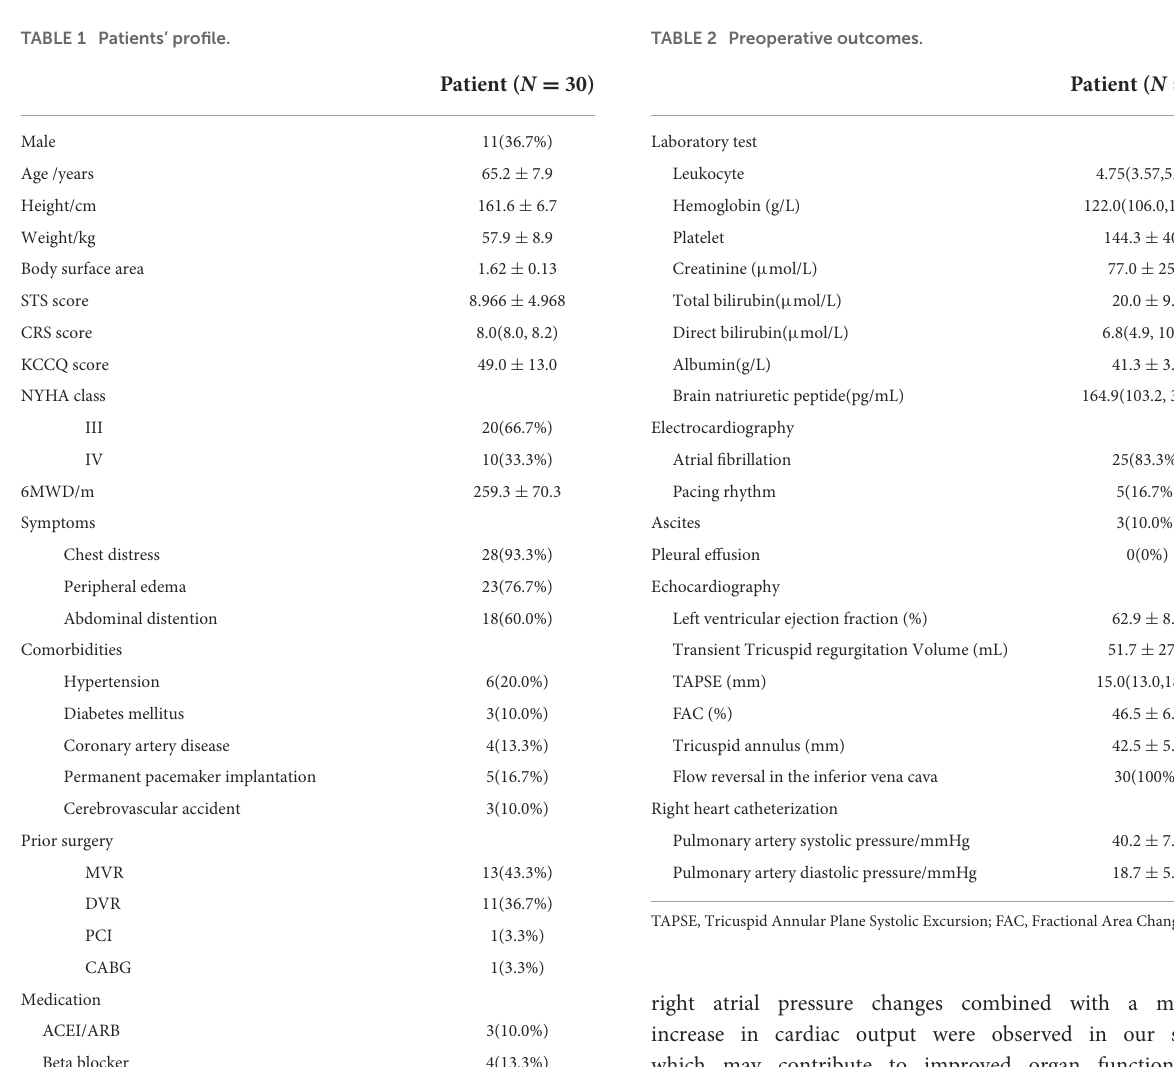
TABLE 1 Patients’ profile. TABLE 2 Preoperative